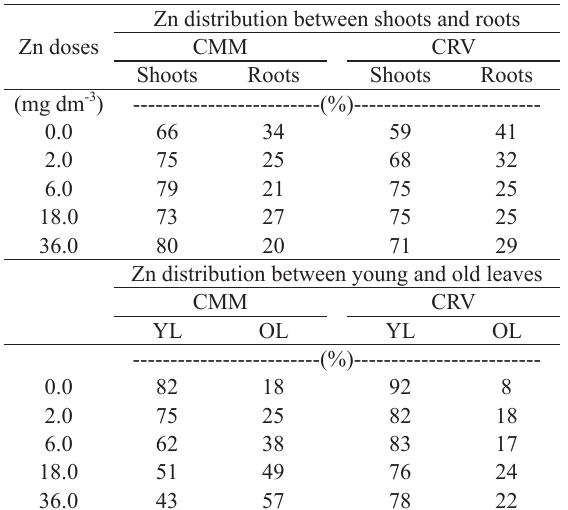
Zinc distribution between shoots and roots and between young and old leaves in lettuce cultivars CMM and CRV, 44 days after seedlings transplanting to soil treated with Zn.